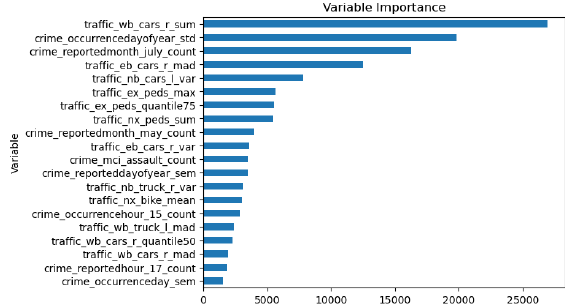
Figure 4 . Top 20 important variables from 80 by 80 models.